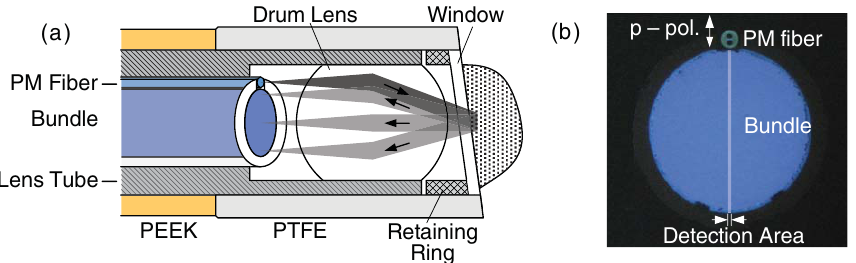
Fig. 3. Design of the distal end of the fiber probe used in the clinical a/LCI system. (a) Probe tip assembly showing sample illumination and scattering detection with fiber bundle. (b) Collection fiber bundle and delivery PM fiber with detection area highlighted. Adapted from Ref.